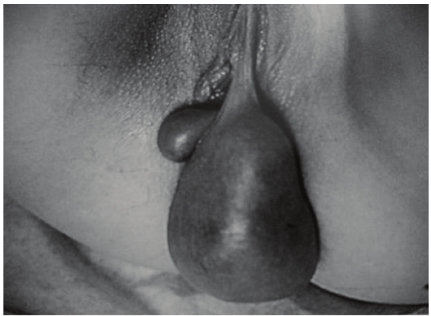
Figure 1: The tumor shows a pedunculated large mass arising from the labia minora with a subtle